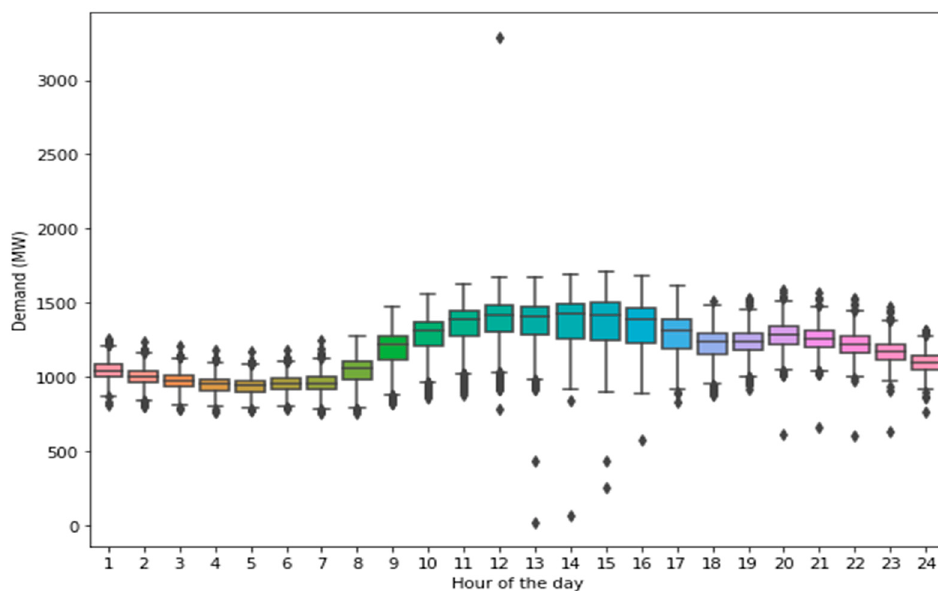
Figure 8. Boxplot of hourly consumption. The diamond symbol represents the outliers.